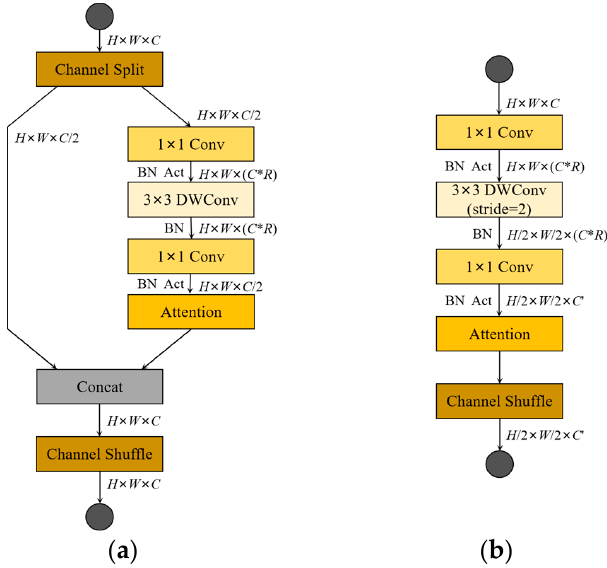
Figure 5. Building blocks of our work (LWC). ( a ) The basic unit (stride set to one); ( b ) the spatial downsampling unit (stride set to two). DWConv denotes depthwise convolution. R denotes expansion rate. Act denotes activates the function. Attention denotes the attention mechanism.